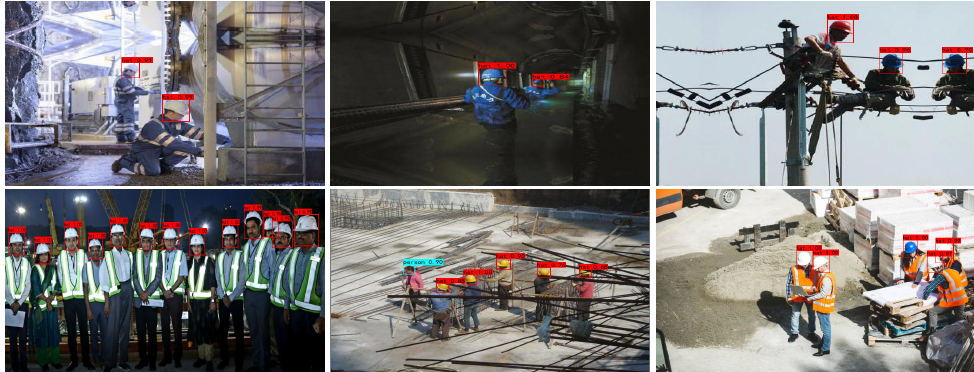
Figure 12. The three images in the first row are from Hard Hat Dataset and the three images in the second row are from Helmet